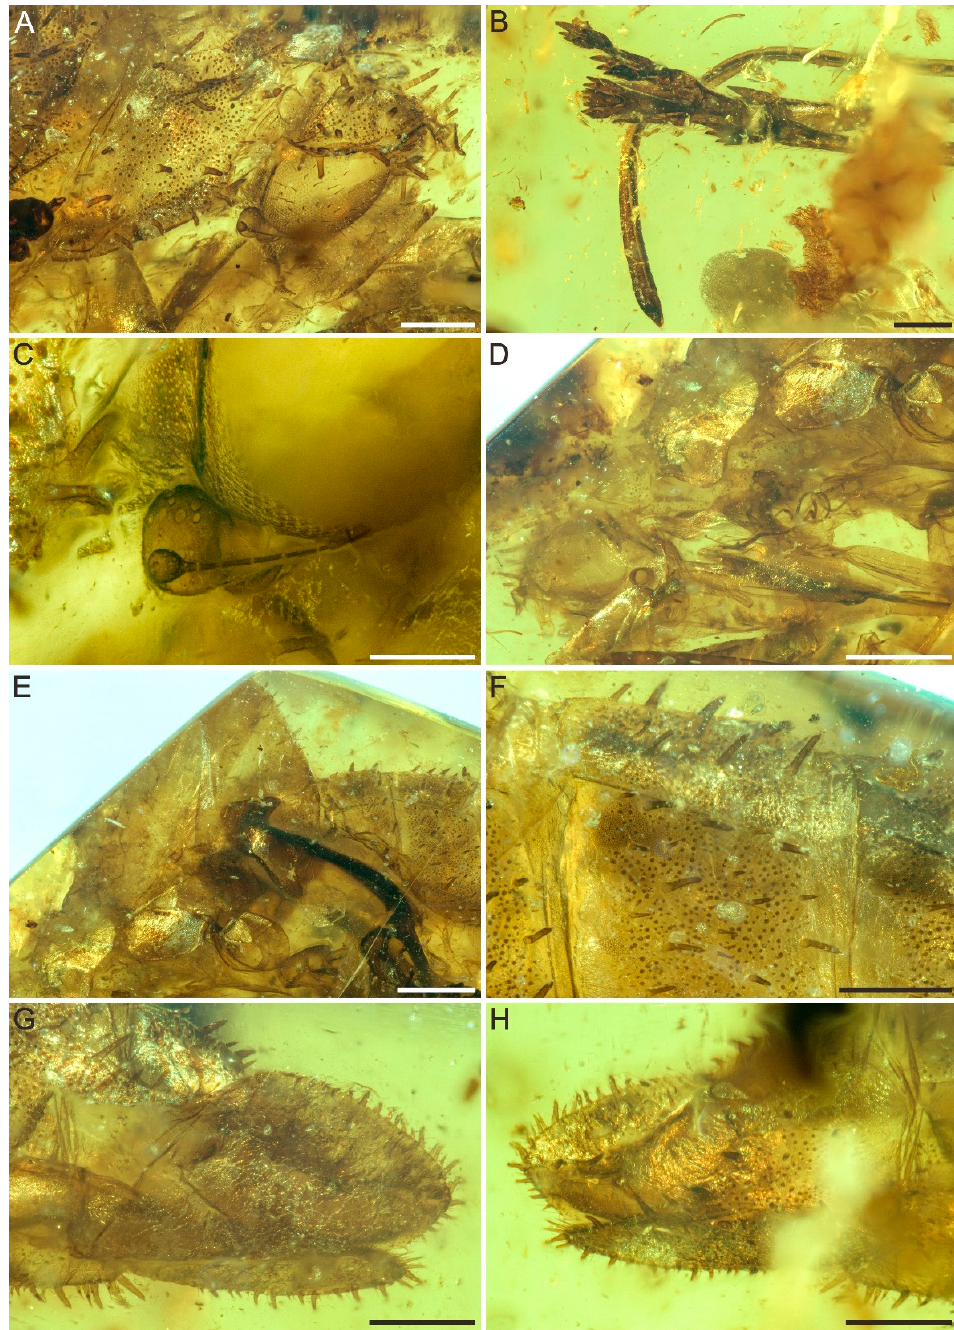
Figure 2. Detailed photographs of the head, pronotum, mesonotum, and metanotum of Spinonympha shcherbakovi gen. et sp. nov. ( A ) Head and pronotum in right lateral view. ( B ) Apex of rostrum in right lateral view. ( C ) Antenna in right lateral view. ( D ) Pronotum and mesonotum in left lateral view. ( E ) Metanotum in left lateral view. ( F ) Spines and tubercles of abdomen in left lateral view. ( G ) Pygofer in left lateral view. ( H ) Pygofer in right lateral view. Scale bars for ( D , E ) = 1.0 mm; ( A , B , F – H ) = 0.5 mm; ( C ) = 0.2 mm.